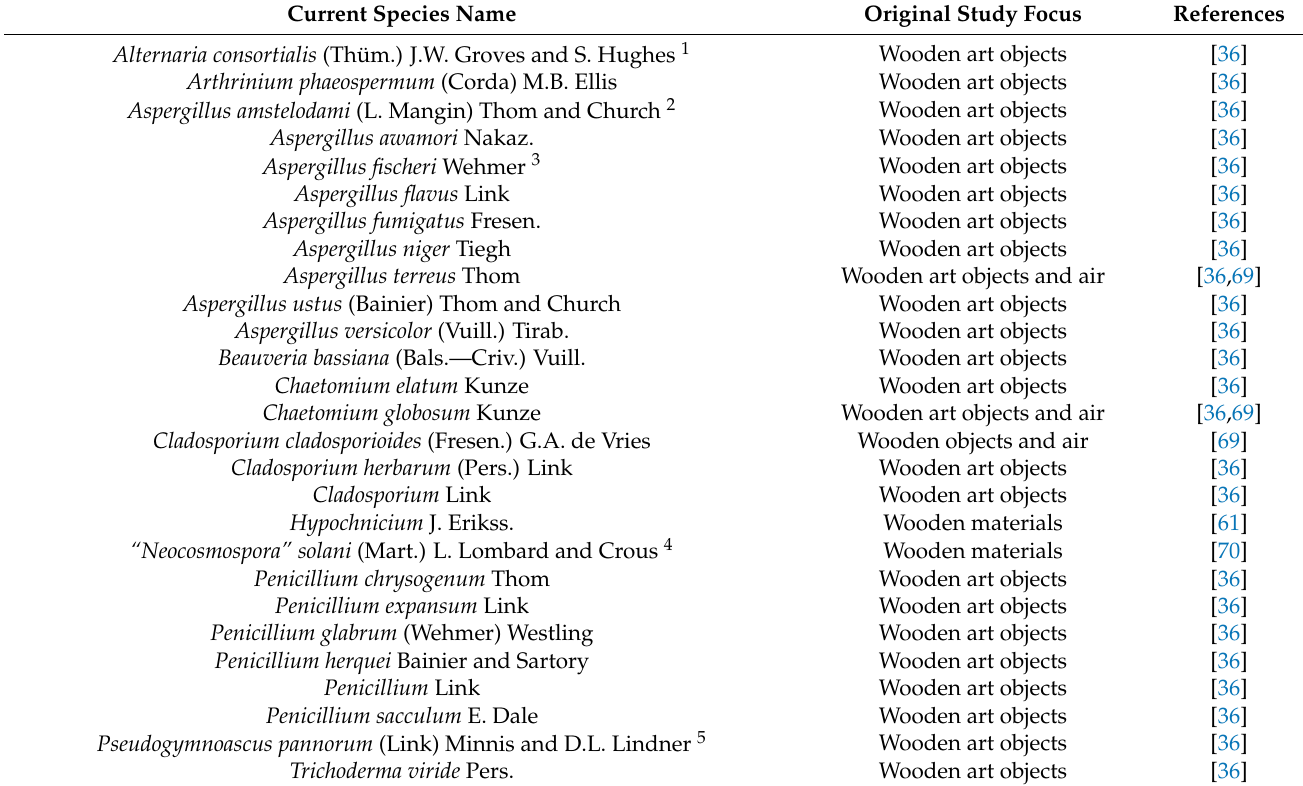
Table 5. Overview of fungal species for which isolates have been identified as displaying keratinolytic abilities in biodeteri- orative plate essays.